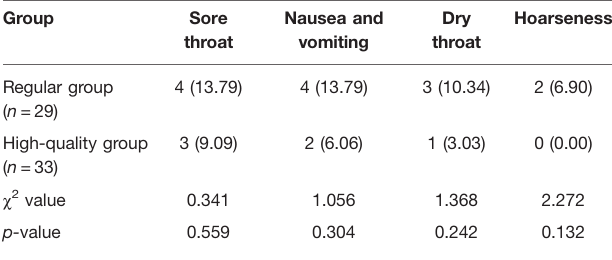
TABLE 3 | Comparison of the occurrence of postoperative pharyngeal complications between the two groups ( n ,%).